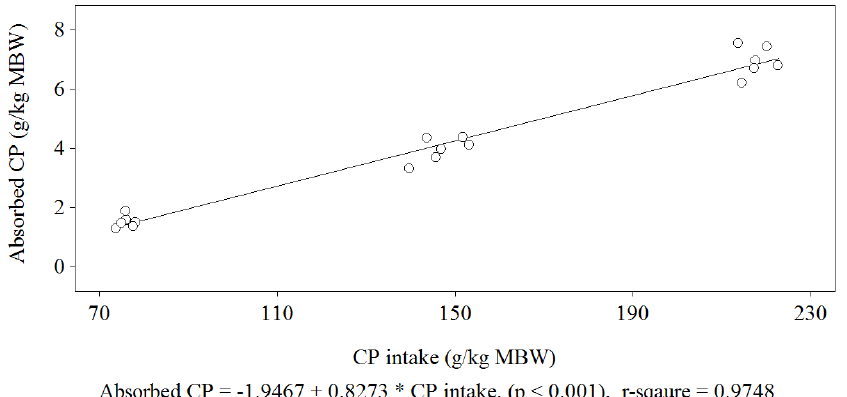
Figure 3. Regression equation of daily absorbed crude protein (CP) according to daily CP intake by female spotted deer (MBW = BW 0.75 ) (MBW, metabolic body weight; BW, Body